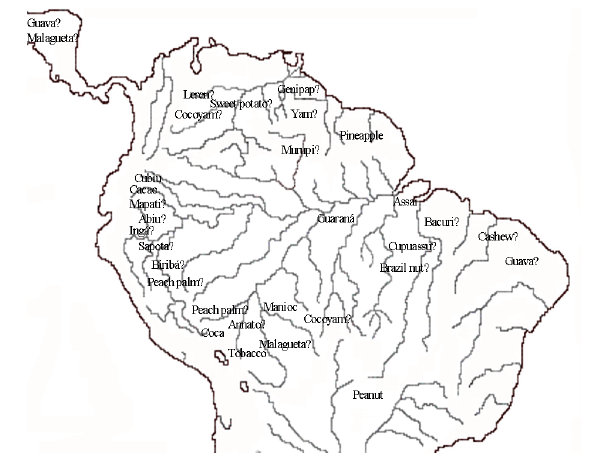
Figure 3. Confirmed and hypothetical origins of some native Amazonian crops. The confirmed origins are (from north to south): pineapple, cubiu ( Solanum sessiliflorum ), cacao, assai ( Euterpe oleracea ), guaraná, manioc, coca ( Erythroxylum coca ), tobacco ( Nicotiana tabacum ), peanut ( Arachis hypogaea ). The hypothetical origins are: genipap ( Genipa americana ), leren ( Calathea allouia ), sweet potato ( Ipomoea batatas ), cocoyam ( Xanthosoma sagittifolium ), yam ( Dioscorea trifida ), murupi pepper ( Capsicum chinense ), mapati ( Pourouma cecropiifolia ), abiu ( Pouteria caimito ), bacuri ( Platonia insignis ), inga ( Inga edulis ), cashew ( Anacardium occidentale ), sapota ( Quararibea cordata ), cupuassu, biriba ( Rollinia mucosa ), guava ( Psidium guajava ), Brazil nut, peach palm, cocoyam, annato ( Bixa orellana ), malagueta pepper ( Capsicum frutescens ). Note that there